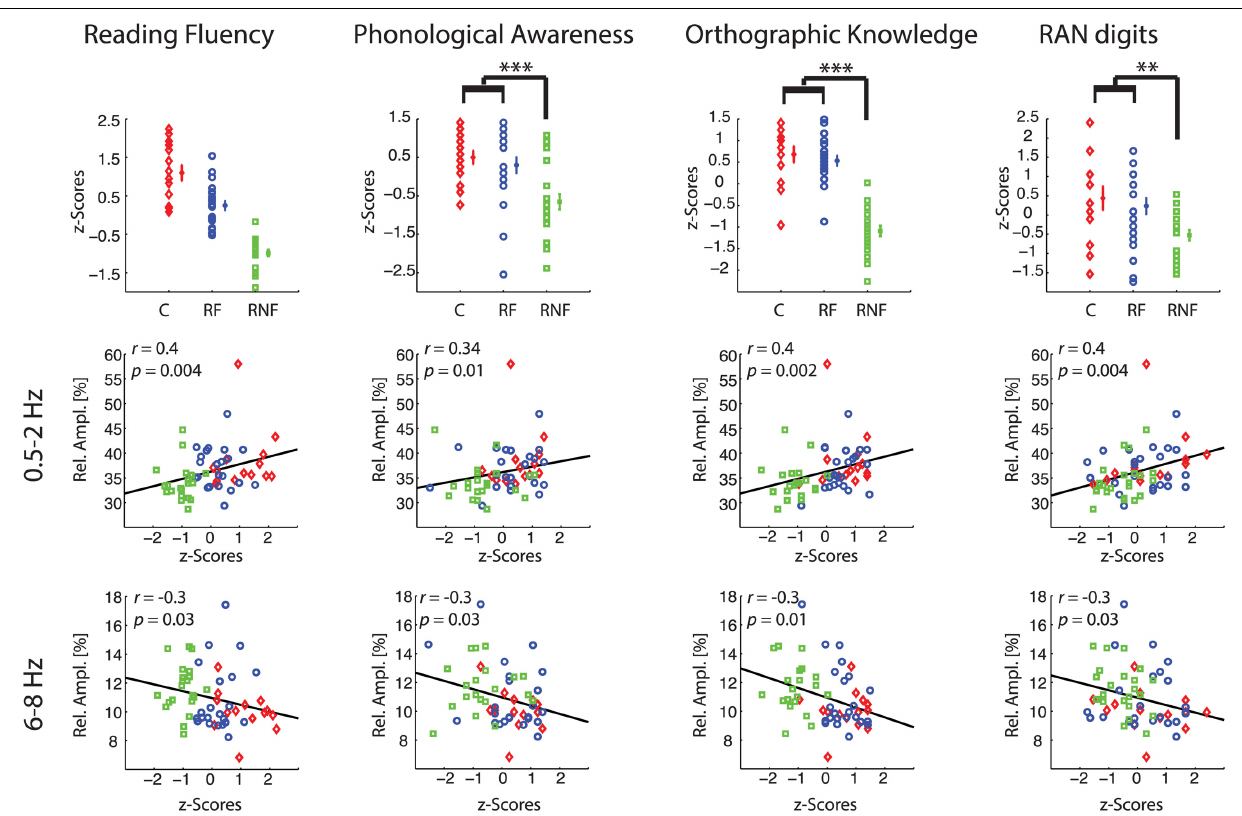
FIGURE 4 | Correlations between behavioral and neurophysiological measures. Each column refers to a specific behavioral task. Plots in the first row illustrate individual-subject z-scores, across subject means, and standard error bars for each group (control, C, small red diamonds; at-risk fluent readers, RF, blue circles; at-risk non-fluent readers, RNF, green squares). The asterisks indicate p- values of the statistics in Table 1 ( ∗∗ p = 0 . 005; ∗∗∗ p = 0 . 001). For the reading fluency assessment